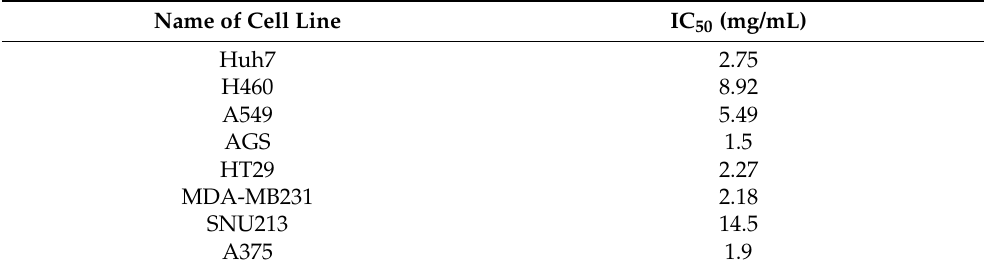
Table 2. Value of HO-1089 on the growth of human cancer cell lines.